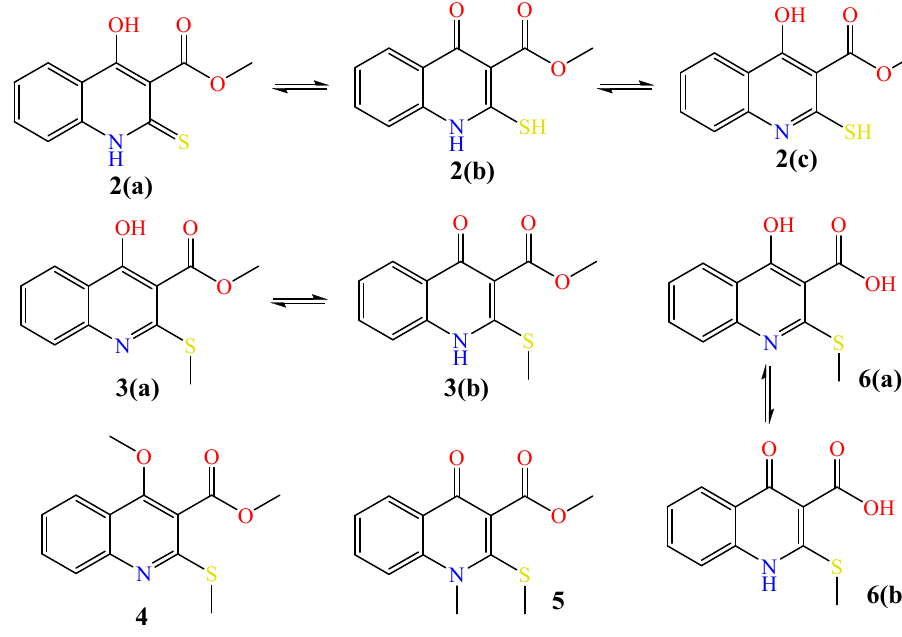
Figure 11. The molecular systems ( 2 – 6 ) under consideration for the docking procedure. Table 2. Molecular Docking Parameters for the systems under